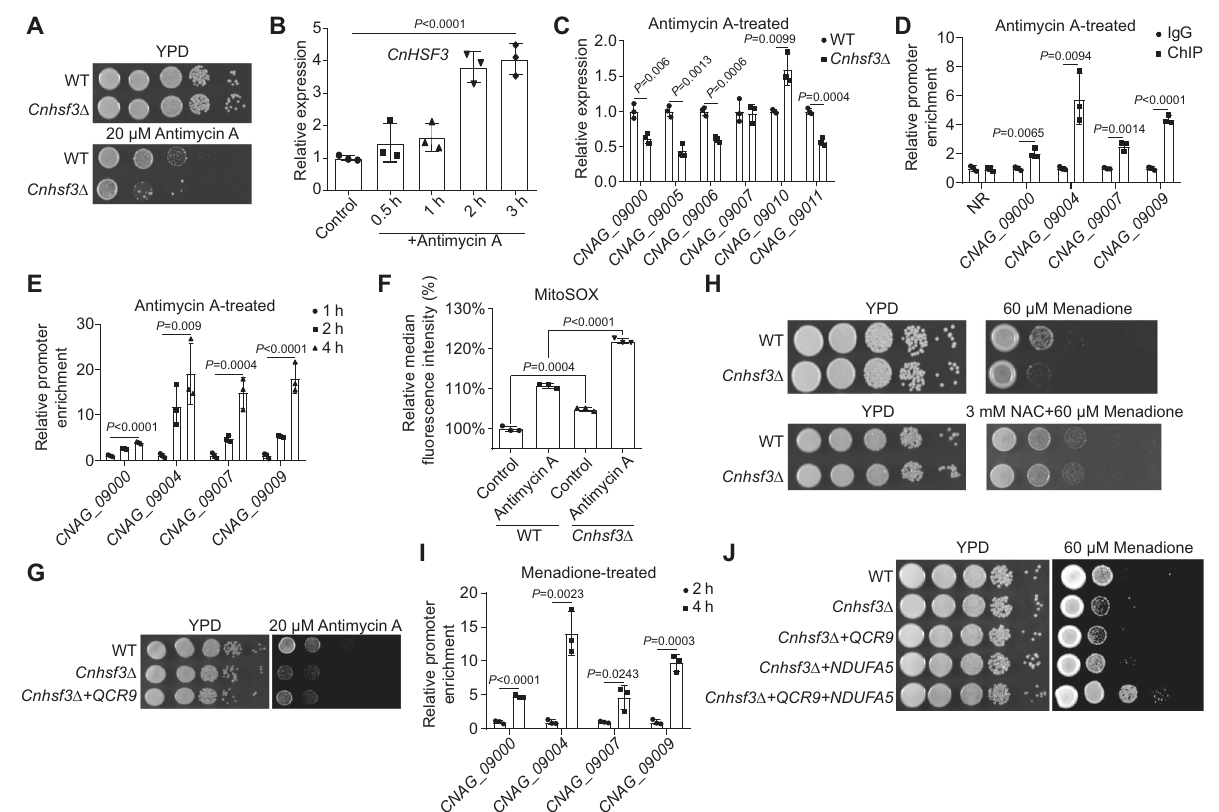
Fig. 6 | Cn Hsf3 protects mitochondria from oxidative stress. A Effect of anti- mycinAoncellgrowthin Cnhsf3 Δ . B CnHSF3 expressioninresponsetoantimycinA. Wildtypecells( n =3)weretreatedwith10 μ MantimycinA,thenafter0.5,1,2,or3h of incubation, RNA was isolated, and qRT-PCR was used to quantify CnHSF3 . One- wayANOVA tests wereused. C Quanti fi cation of Cn Hsf3targetgenes. RNA isolates from wildtype and Cnhsf3 Δ strains ( n =3) treated with 10 μ M antimycin A for 3h were analyzed to quantify the indicated Cn Hsf3 target genes, determining gene expression. Two-tailed unpaired t -tests were used. D ChIP-PCR for Cn Hsf3 target genes in response to antimycin A. Cells ( n =3) were treated asdescribed in C , then ChIP-PCR was performed. An NR (nonregulated mitochondrial region by Cn Hsf3) was used as a negative control. Two-tailed unpaired t -tests were used. E ChIP-PCR for Cn Hsf3targetgenes.Cells( n =3)wereincubatedwith10 μ MantimycinAfor1,2, or 4h, then ChIP-PCR was performed. One-way ANOVA tests were